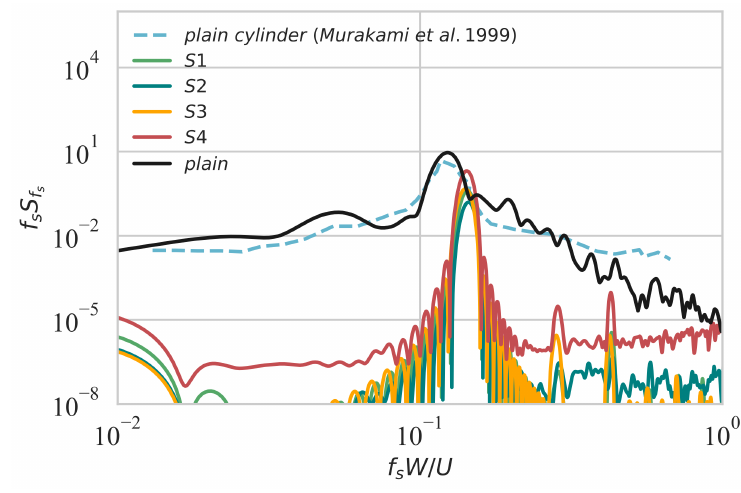
Figure 9. Power spectra of lift forces for the four stationary cases and plain cylinder.